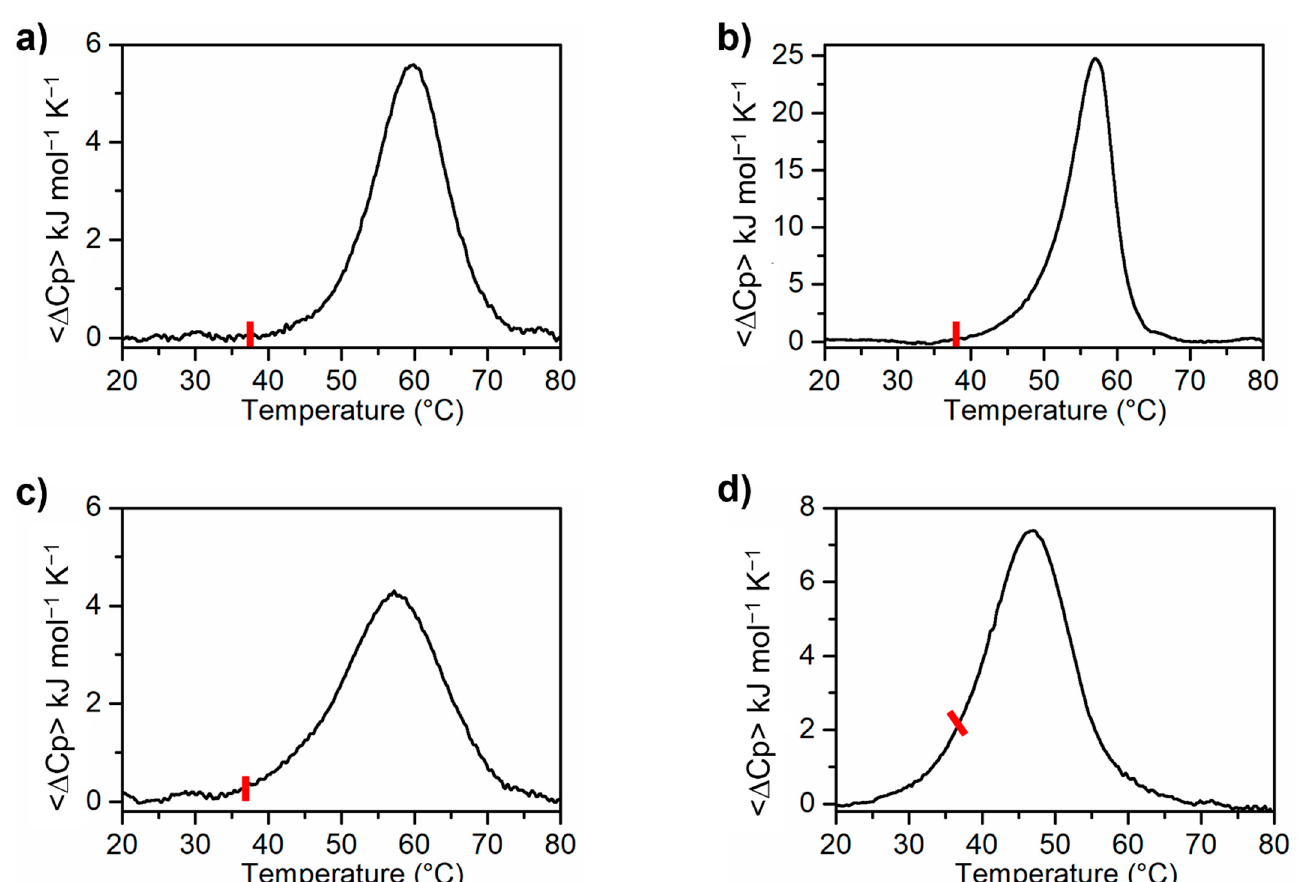
Figure 4. Experimental DSC profiles for MS3-33 ( a ) and MS3-17 ( c ) in PBS buffer (137 mM NaCl, 2.7 mM KCl, 10 mM NaH 2 PO 4 /Na 2 HPO 4 , 1.8 mM KH 2 PO 4 /K 2 HPO 4 , pH = 7.4); DSC profiles for MS3-33 ( b ) and MS3-17 ( d ) in the Na + buffer (10 mM NaH 2 PO 4 /Na 2 HPO 4 , 90 mM NaCl solution, pH = 7.0). The red bar indicates the physiological temperature. Table 3. Thermodynamic parameters obtained by the differential scanning calorimetry profiles. The error on T m determination is ±1.0 °C and on Δ H° is ±10%.